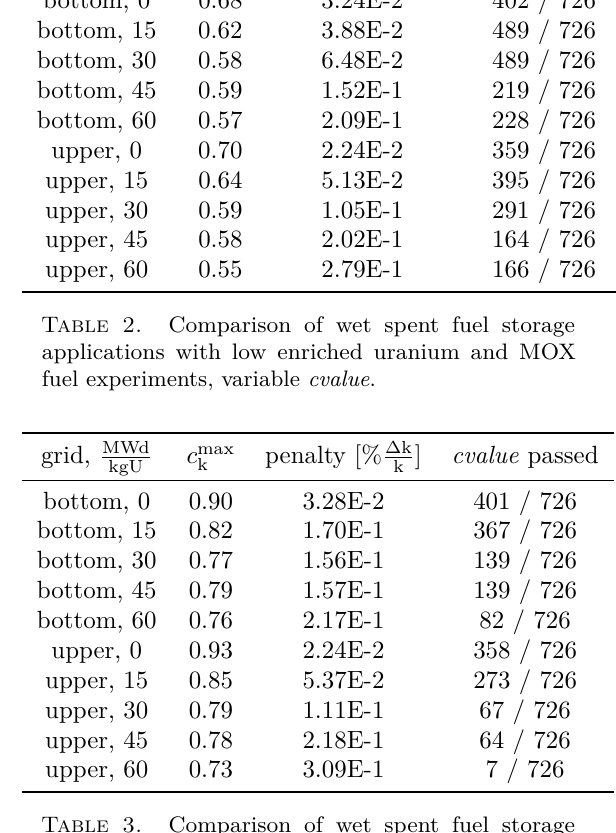
Table 3. Comparison of wet spent fuel storage applications with low enriched uranium and MOX fuel experiments, cvalue =0.7